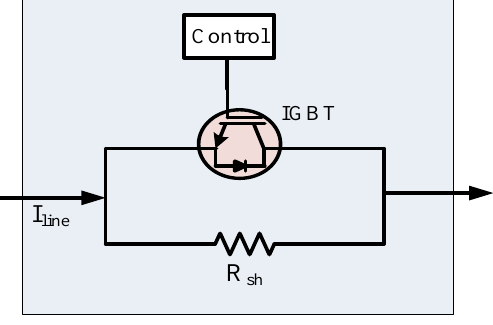
Figure 9. Series dynamic breaking resistor (SDBR) Configuration.